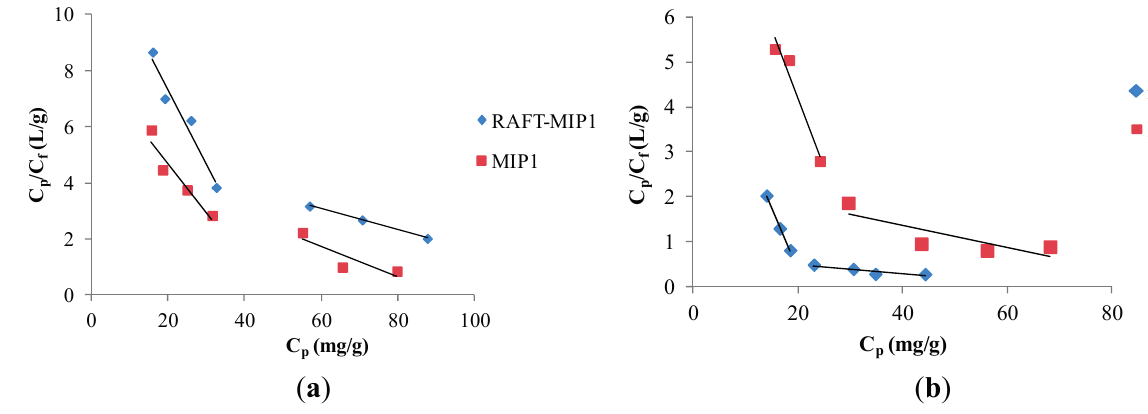
Figure 9. Scatchard plot of ( a ) RAFT-MIP1 and MIP1; and ( b ) RAFT-MIP2 and